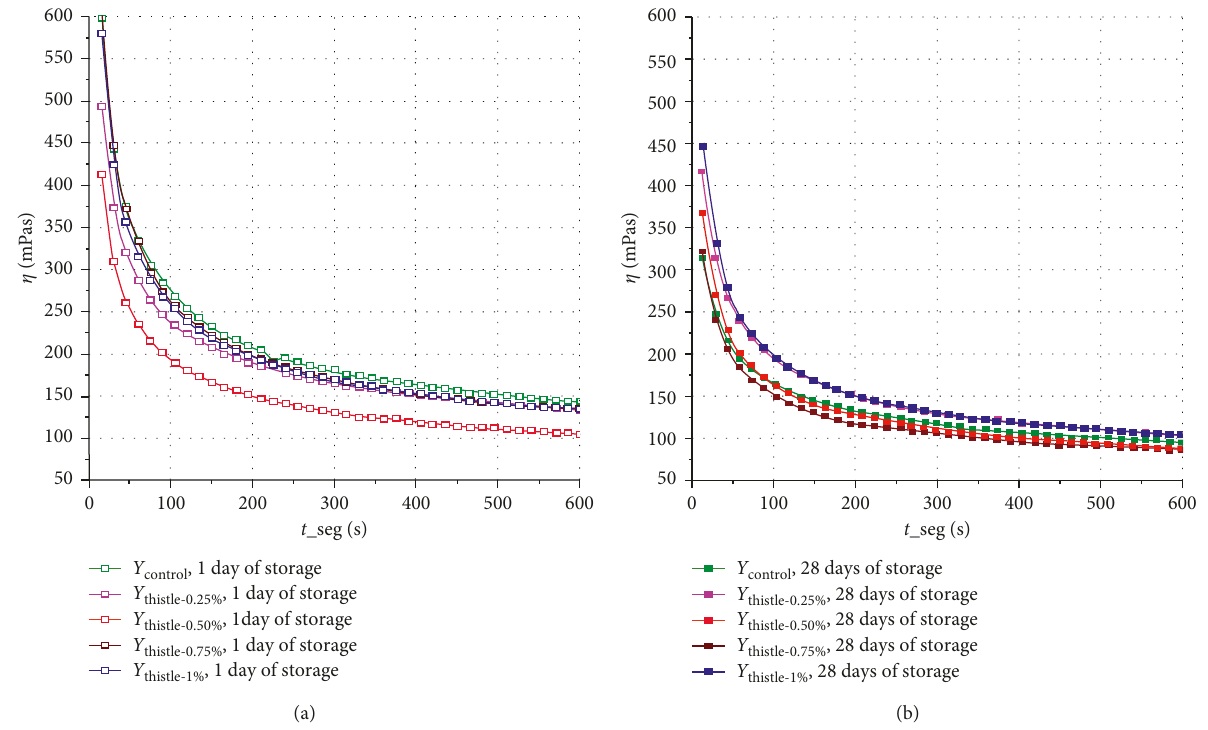
Figure 1: Curve of viscosity versus time of testing thixotropy of yogurt with thistle ( Silybum marianum L.) extract: (a) 1 day of storage; (b) after 28 days of